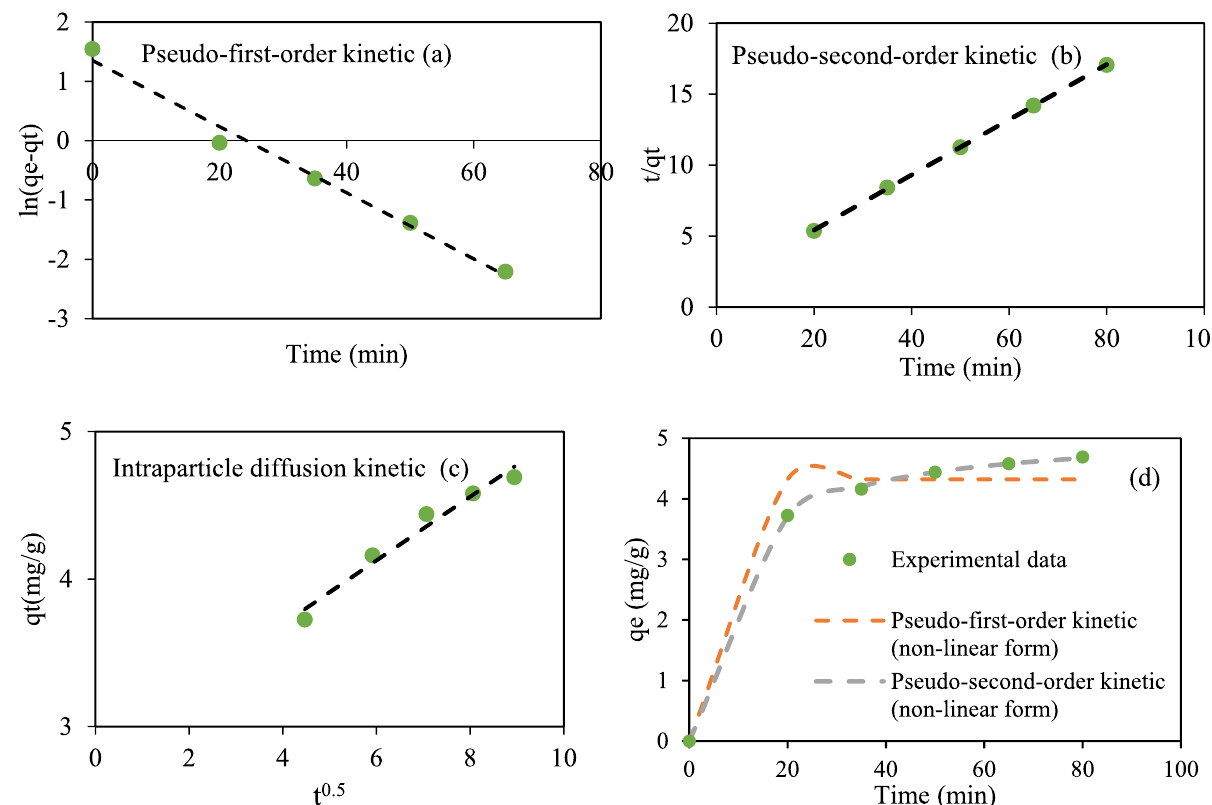
Figure 10. Linear and nonlinear kinetic models for RR 198 adsorption by MSW compost